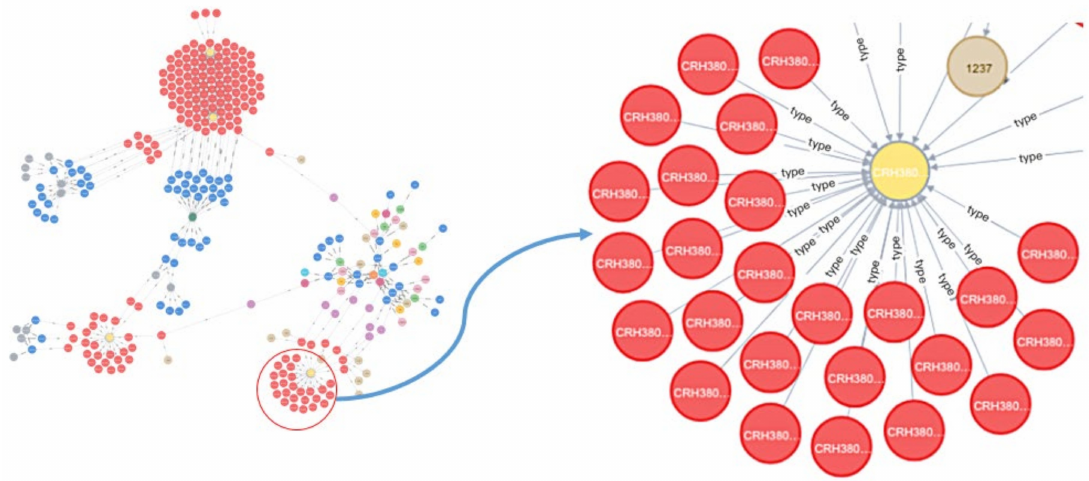
Figure 6. Train fault knowledge graph. The related attributes of each train were constructed by the atlas, which can express the relationship between the train, different faults, and fault causes in a clear manner. The left side shows the panoramic effect of train fault analysis, and the right side shows the enlarged effect within the specified